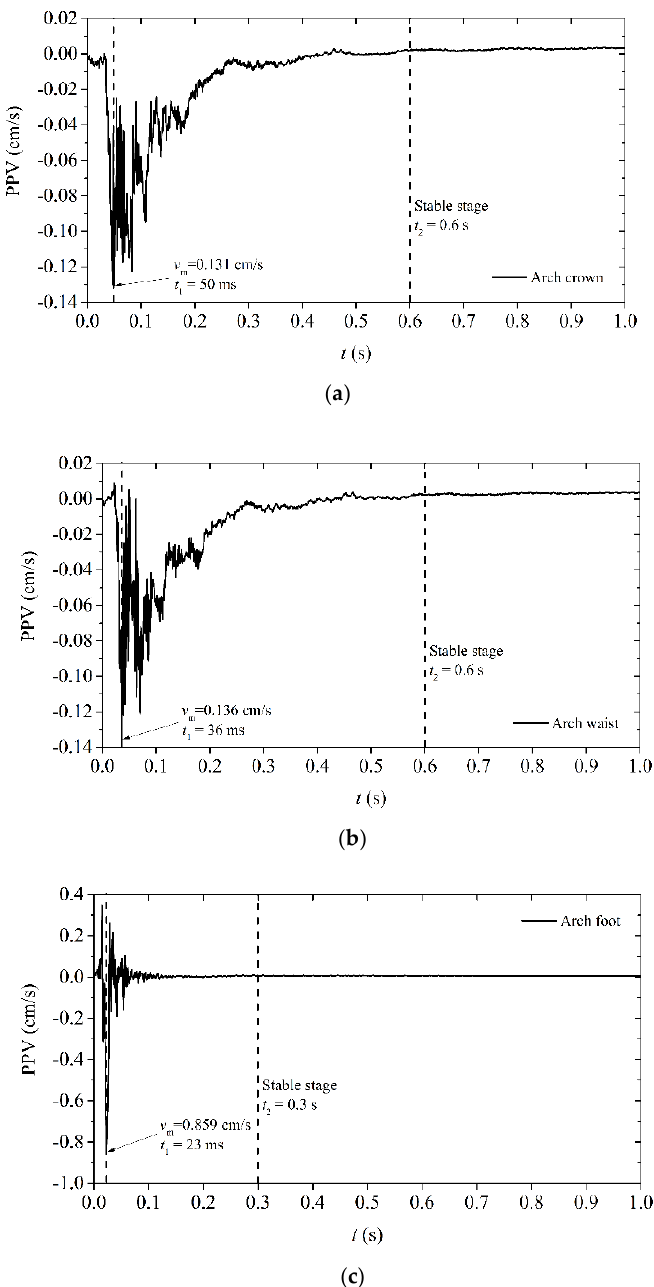
Figure 14. Dynamic responses of secondary lining induced by blasting the lower rock: ( a ) Arch crown; ( b ) Arch waist; ( c ) Arch foot.